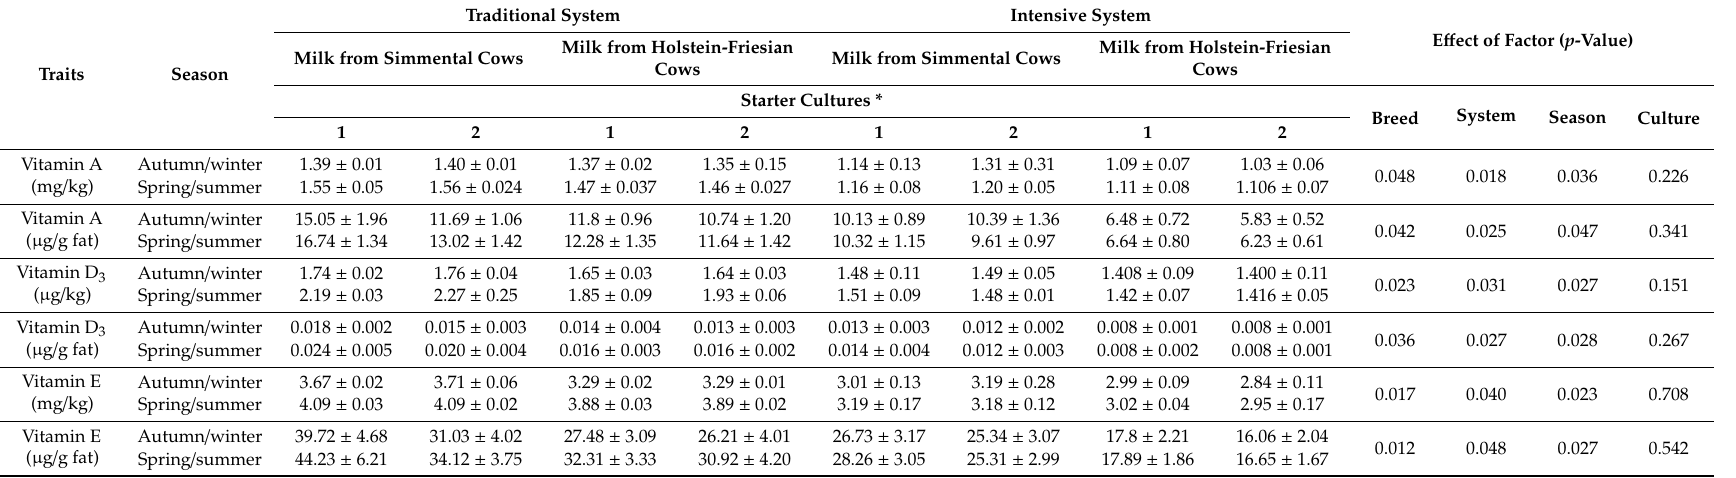
Table 3. Content of selected fat-soluble vitamins in acid curd cheese (tvarog), depending on the experimental factors ( x ±